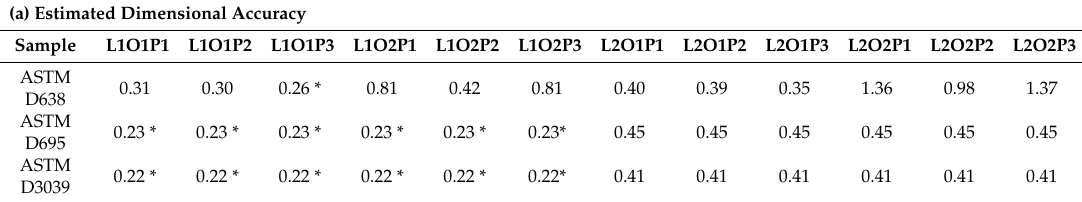
Table Table 9. Estimated dimensional accuracy of each parameter combination and the fitted regression models.